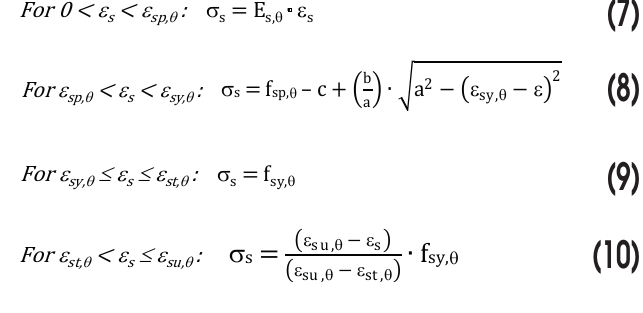
/E for reinforcing steel S, θ S